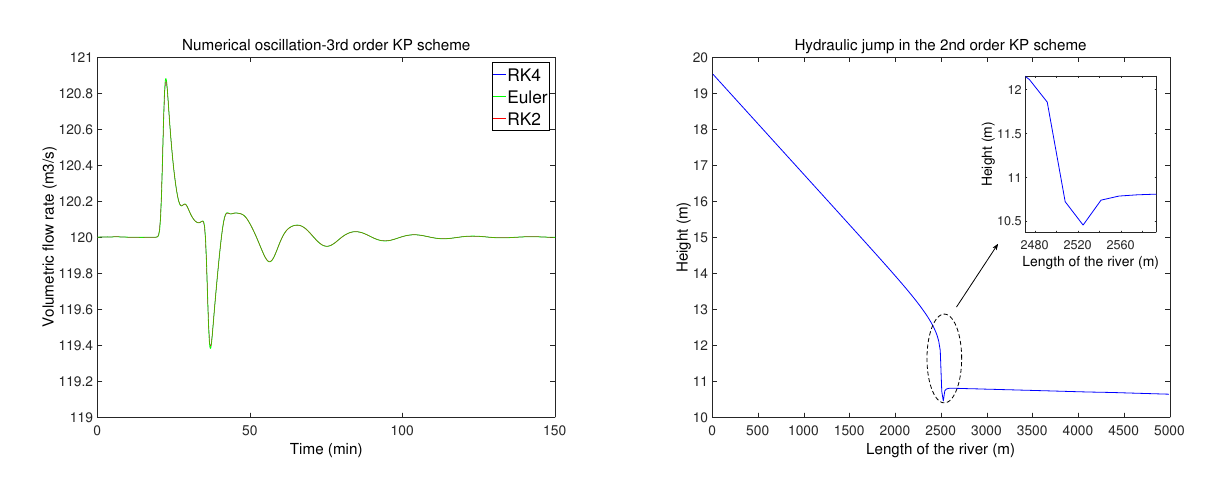
Figure 17: Numerical oscillation for all fixed step- Figure 18: Hydraulic jump for 2 nd order KP scheme. length solvers for 3 rd order KP scheme.